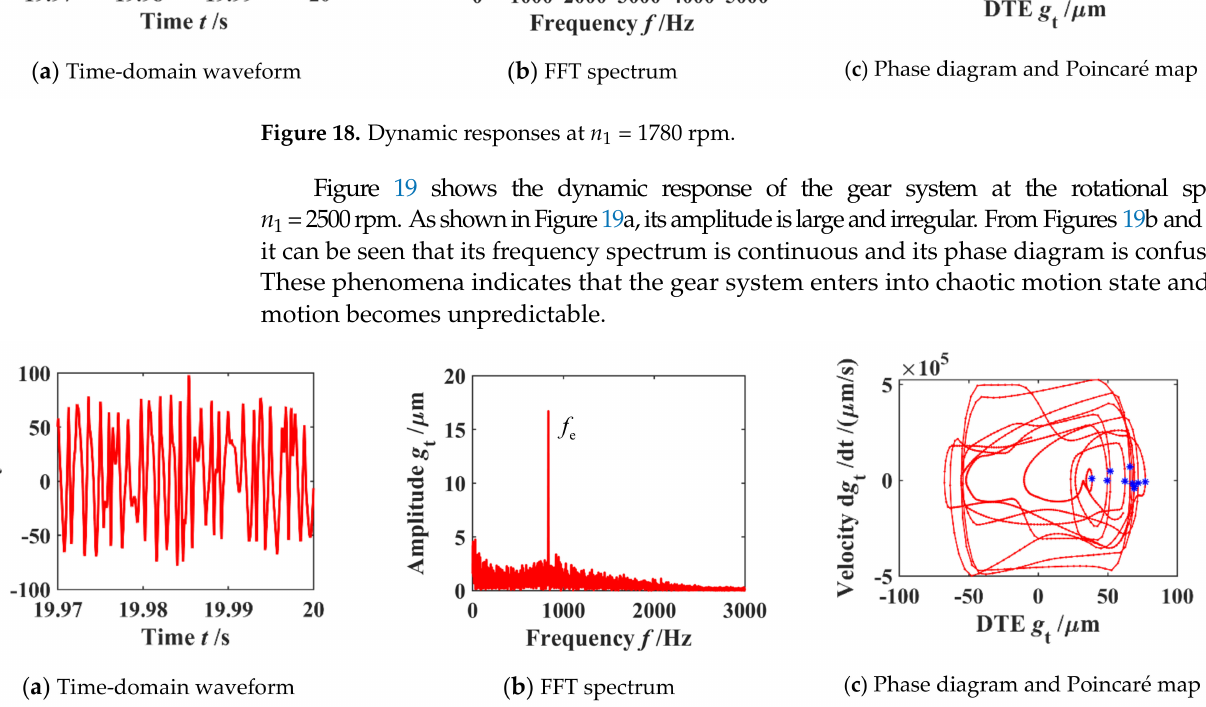
Figure 19. Dynamic responses at n 1 = 2500